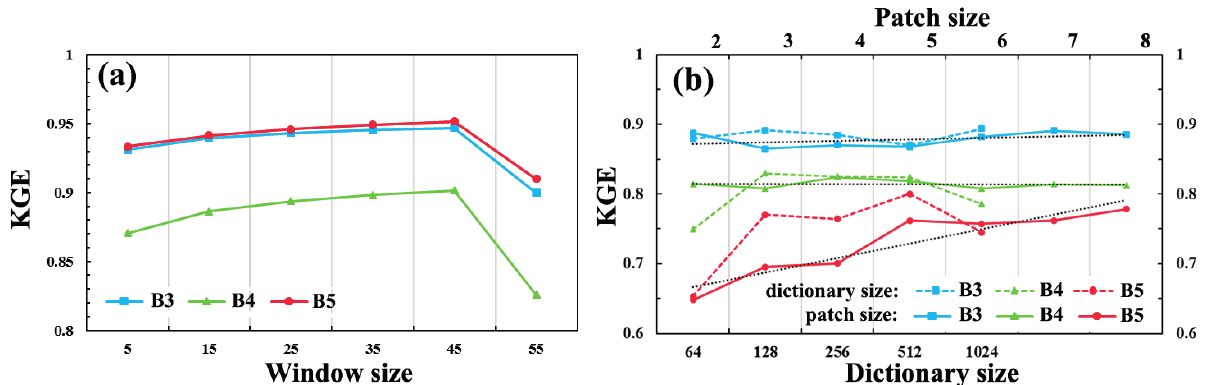
Figure 13. Model parameters affect the KGE. ( a ) Changes in the KGE of the three key bands as the moving window size increases; ( b ) Changes in the KGE of two bands as the dictionary (bottom axis) and patch (upper axis) sizes